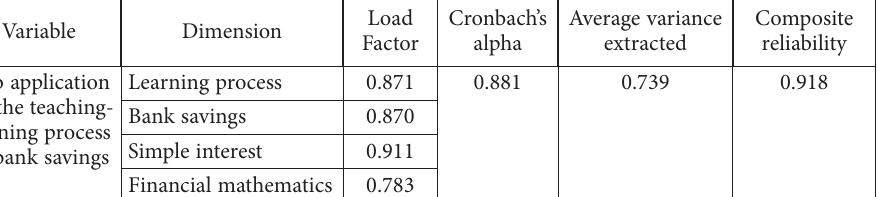
Table 3. Validation of the questionnaire (source: created by authors) Variable Dimension Web application for the